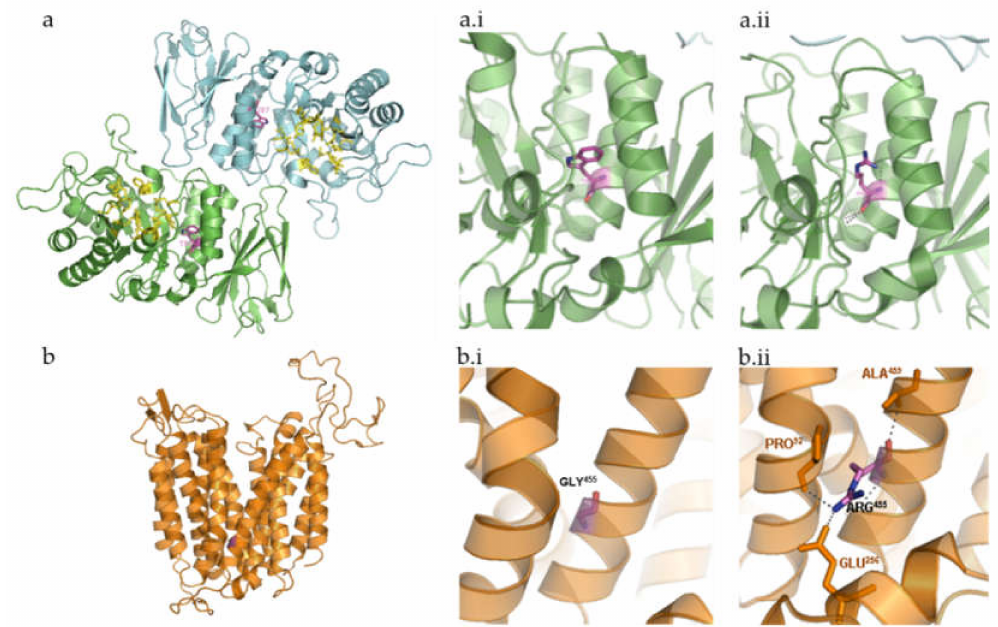
Figure 3. Three-dimensional structure representation of α -galactosidase (GLA) and major facilitator superfamily domain containing 8 (MFSD8) using PyMol. β -strands, helices, and coils indicate the secondary structure elements that form the sca ff old for the interacting residues. Relevant side chains that interact with the residues of interest are depicted and labelled. ( a ) Human GLA dimer, shown in ribbon representation (Protein Data Bank accession code = 1R46). Each monomer of the homodimer contains two domains, α ( β / α ) 8 barrel containing the active site plus a C-terminal antiparallel β domain. Active site residues are shown in yellow (Trp 47 , Asp 92 , Asp 93 , Tyr 134 , Cys 142 , Lys 168 , Asp 170 , Glu 203 , Leu 206 , Tyr 207 , Arg 227 , Asp 231 , Asp 266 , Met 267 ). Relevant side chains that interact with the residue of interest are depicted and labelled. α -galactosidase A dimer, with the active site residues and the a ff ected amino acid highlighted; ( a.i ) wild-type Trp 287 ; ( a.ii )—mutated Arg 287 ; ( b ) in silico design of MFSD8 three-dimensional structure based on sequence analysis and subsequent prediction of